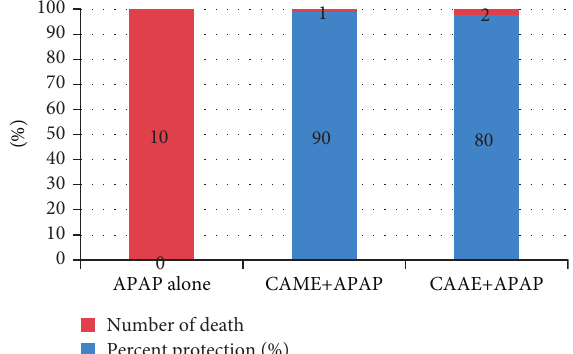
Figure 1: Effects of 80% methanol and aqueous extracts of C. africana stem bark on APAP-induced mortality. (APAP-acetaminophen, CAAE-aqueous extract of C. africana , and CAME-80% methanol extract of C. africana ).